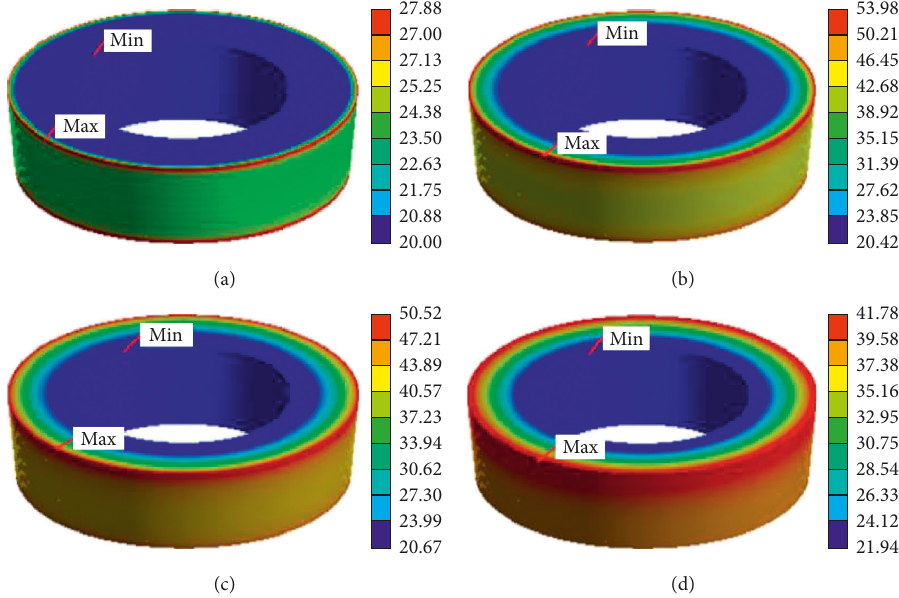
Figure 6: Surface temperature distribution of the target gear ring. (a) t